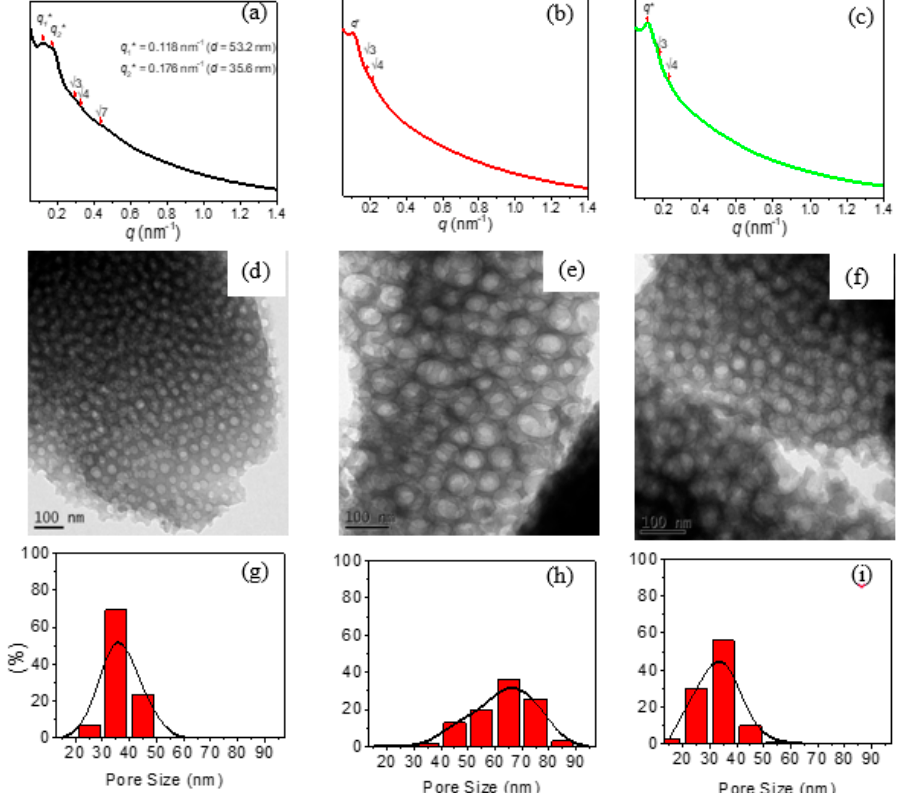
Figure 4. SAXS pattern, TEM image, and the corresponding pore size distribution of mesoporous carbons from phenolic/LED blends of ( a , d , g ) 70/30, ( b , e , h ) 60/40, and ( c , f , i ) 50/50, respectively. Nitrogen sorption isotherms were used to understand the corresponding pore structures of these mesoporous carbons as displayed in Figure 5a, in which typical IV curves all exhibited H 1 -like hysteresis loops. The relative pressure ( P / P 0 ) range from 0.85 to 1.0 was observed for the sharp capillary condensation steps, indicating porous structures with large and cylindrical pores. The results were consistent with the TEM images and SAXS patterns. The corresponding average mesoporous size distribution of these mesoporous carbons based on the Harkins and Jura model were 30.1 ± 11.3, 45.6 ± 11.3, and 44.7 ± 11.4 nm, as displayed in Figure 5b for phenolic/LEL= 70/30, 60/40, and 50/50 blends, respectively. Table 1 summarizes the pore sizes of the mesoporous carbons using BET and TEM analyses, d -spacing from SAXS analyses, surface area, and pore volume. Table 1. Physical properties of ultra-large mesoporous carbons templated by phenolic/PLA- b -PEO- b -PLA blends. Phenolic/LEL d Spacing (X-ray, nm) Pore Size (BET, nm)